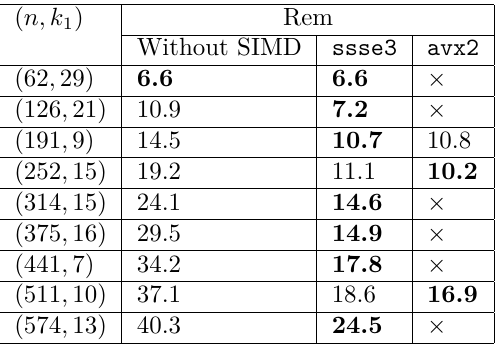
Table 7: Number of cycles to compute the modular reduction of an element F 2 [ X ] of degree 2 n − 2 by f , with MQsoft . We use a Skylake processor